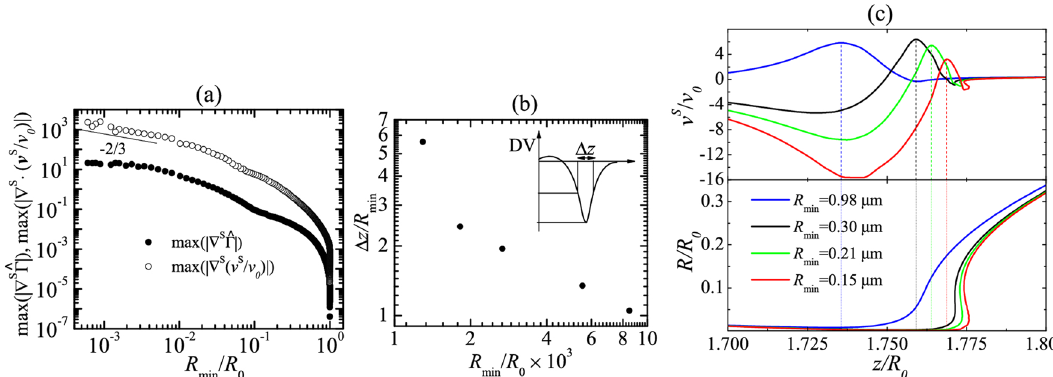
Figure 5. Maximum values of the surfactant gradient, max ( | ∇ ∇ S · v S gradient, max (open symbols). ( b ) Full width at half maximum, Δ z of the dilatational viscous stress as a function of the minimum radius R min . ( c ) Surface velocity ν (cid:30) (cid:30)(cid:29) (cid:31)(cid:30) (cid:30) R ( z ) (lower graph). The dashed vertical lines indicate the position of the free surface neck. In all the cases, the results were calculated for DIW+SDS 0.8cmc with { µ dimensionless parameters are B = 3.396 × 10 − 3 , Oh = 0.0151, S ∗ 4.594 × 10 − 4 (see “Methods” section). and Oh 2 =